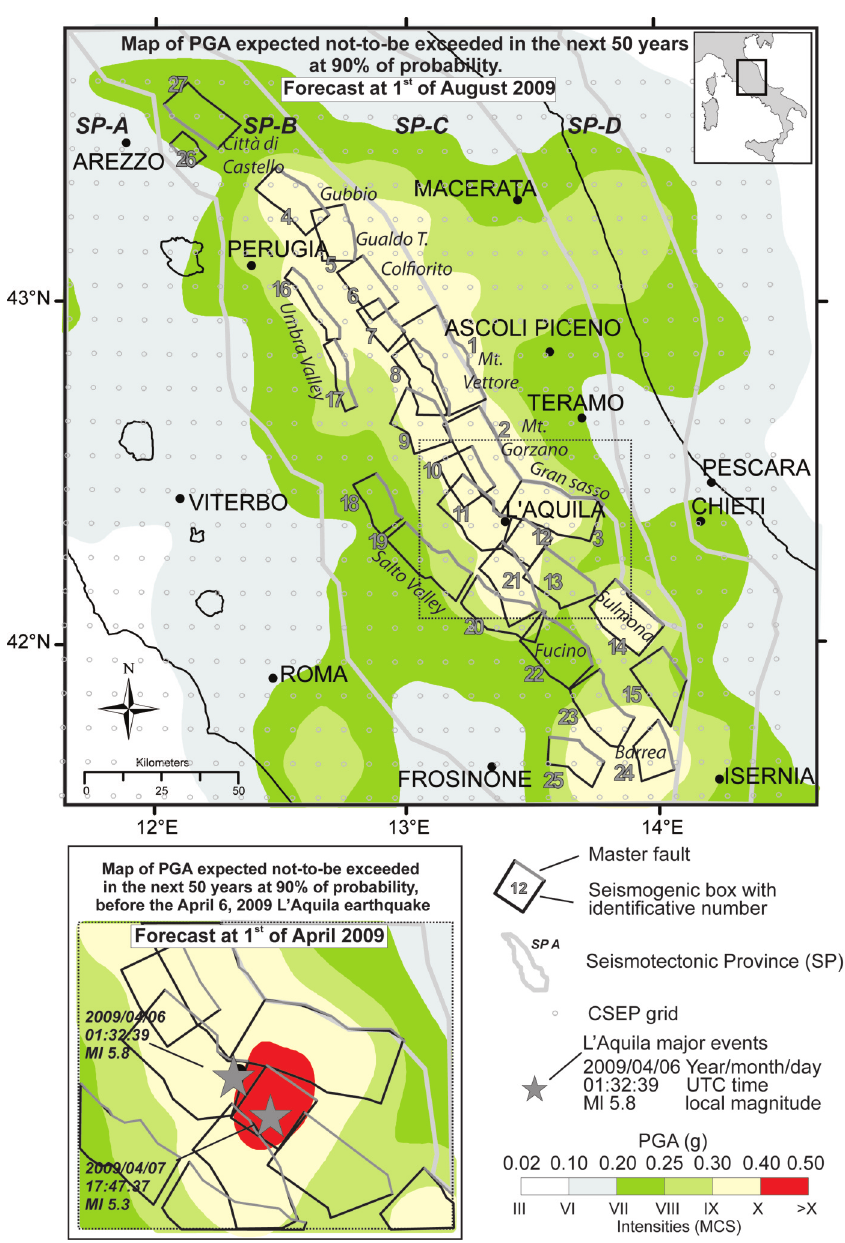
Figure 8. Map of the peak ground acceleration expected not to be exceeded in 50 years at a 90% probability level in central Italy, using the time-dependent LASSCI2009.2, updated for the CSEP validation test. The forecast was for August 1, 2009. The code SEISRISKIII by Bender and Perkins [1987] and the Ambraseys et al. [1996] attenuation relationship were used. The enlargement shows the forecast on April 1, 2009 (release LASSCI2009.1) in the L'Aquila region. The stars show the locations of the major events that were reported. Legend: a rough correlation between peak ground acceleration values and macroseismic intensities (MCS) derived from Italian literature [Margottini et al. 1992, Decanini et al.